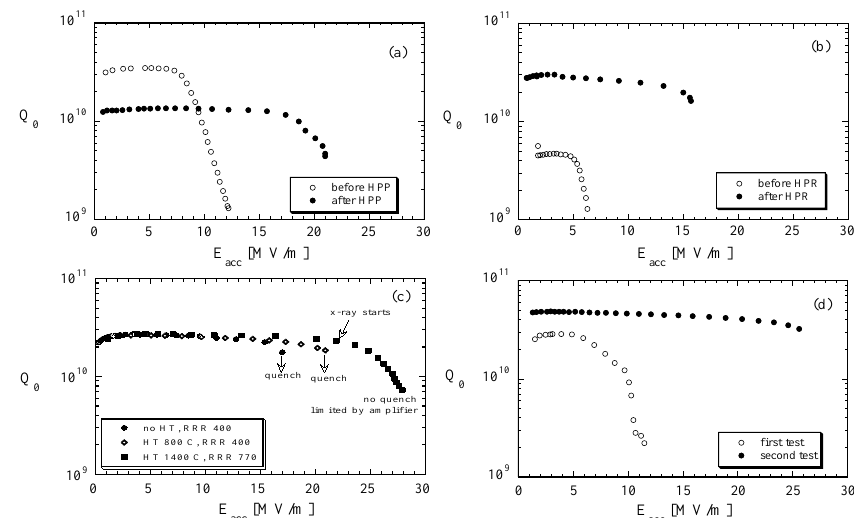
FIG. 13. Improvement in cavity performance due to various treatments: (a) high power processing (HPP), (b) high pressure water rinsing (HPR), (c) successive application of 800 ± C and 1400 ± C heat treatment (HT), and (d) removal of surface defects or titanium in grain boundaries by additional BCP.